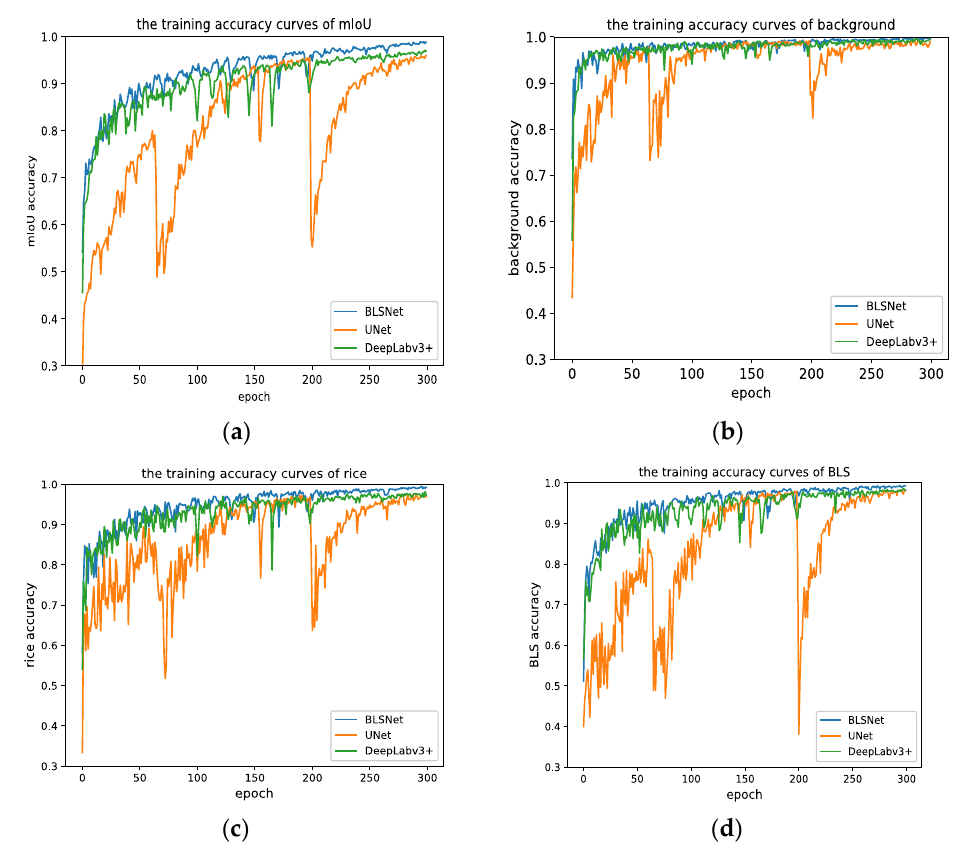
Figure 9. Training accuracy curves of different models. ( a ) The training curves of mIoU of three models; ( b ) the training curves of segmentation accuracy of background of three models; ( c ) the training curves of segmentation accuracy of rice of three models; ( d ) the training curves of segmentation accuracy of BLS of three models.